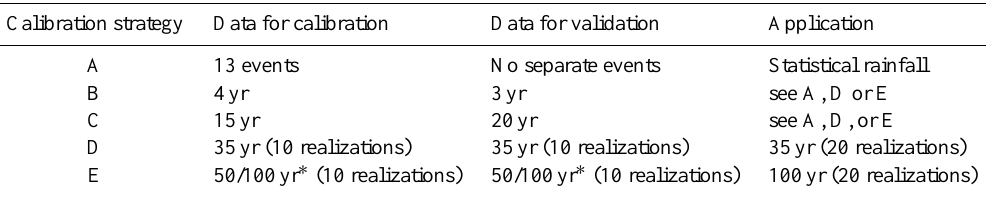
Table 1. Average data volume available for calibration, validation and application for hydrological modeling depending on calibration strategy (see Fig. 4).